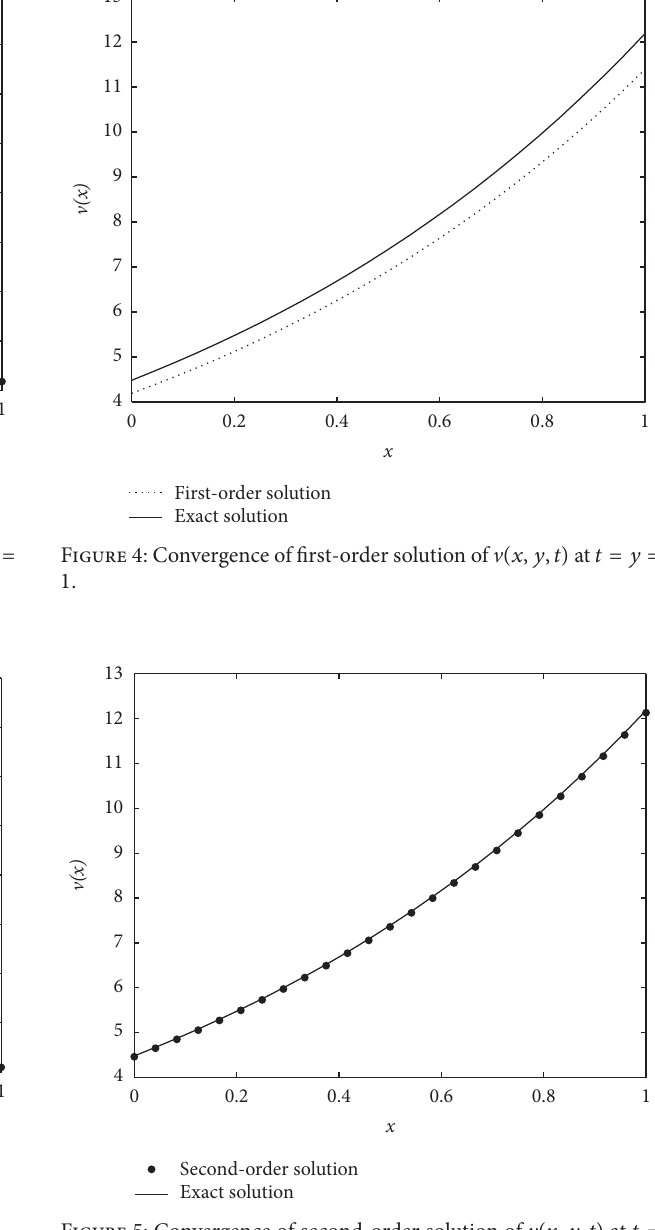
Figure 3: Convergence of third-order solution of 𝑢(𝑥,𝑦, 𝑡) at 𝑡 = 𝑦 = 1 .